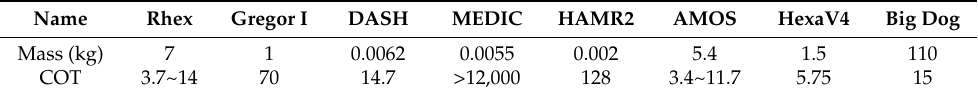
Table 1. Cost of transport of different walking robots: RHex hexapod robot [56]; Gregor I hexapod [57]; DASH hexapod [58]; MEDIC quadruped robot [59]; HAMR2 hexapod microrobot [42]; AMOS